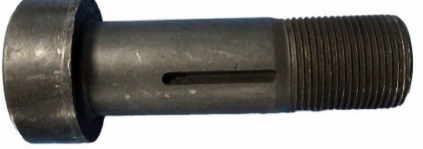
Figure 2. The M60 high-strength bolt used herein.